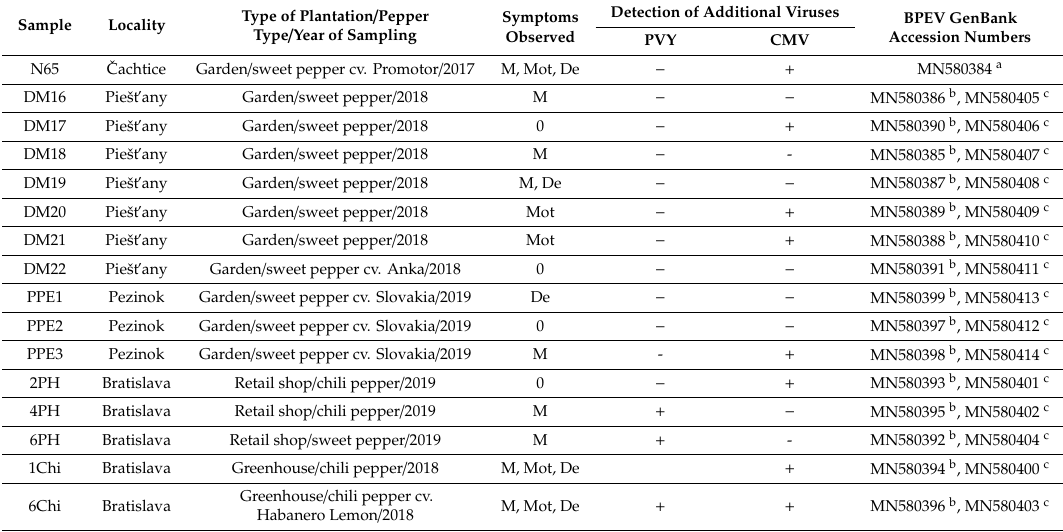
Table 2. List of pepper samples and their characteristics. PVY: potato virus Y.